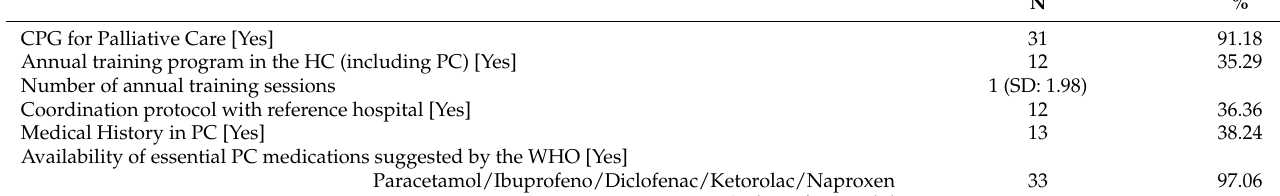
Table 2. Implementation of the Clinical Practice Guide for Palliative Care. CPG for Palliative Care [Yes]